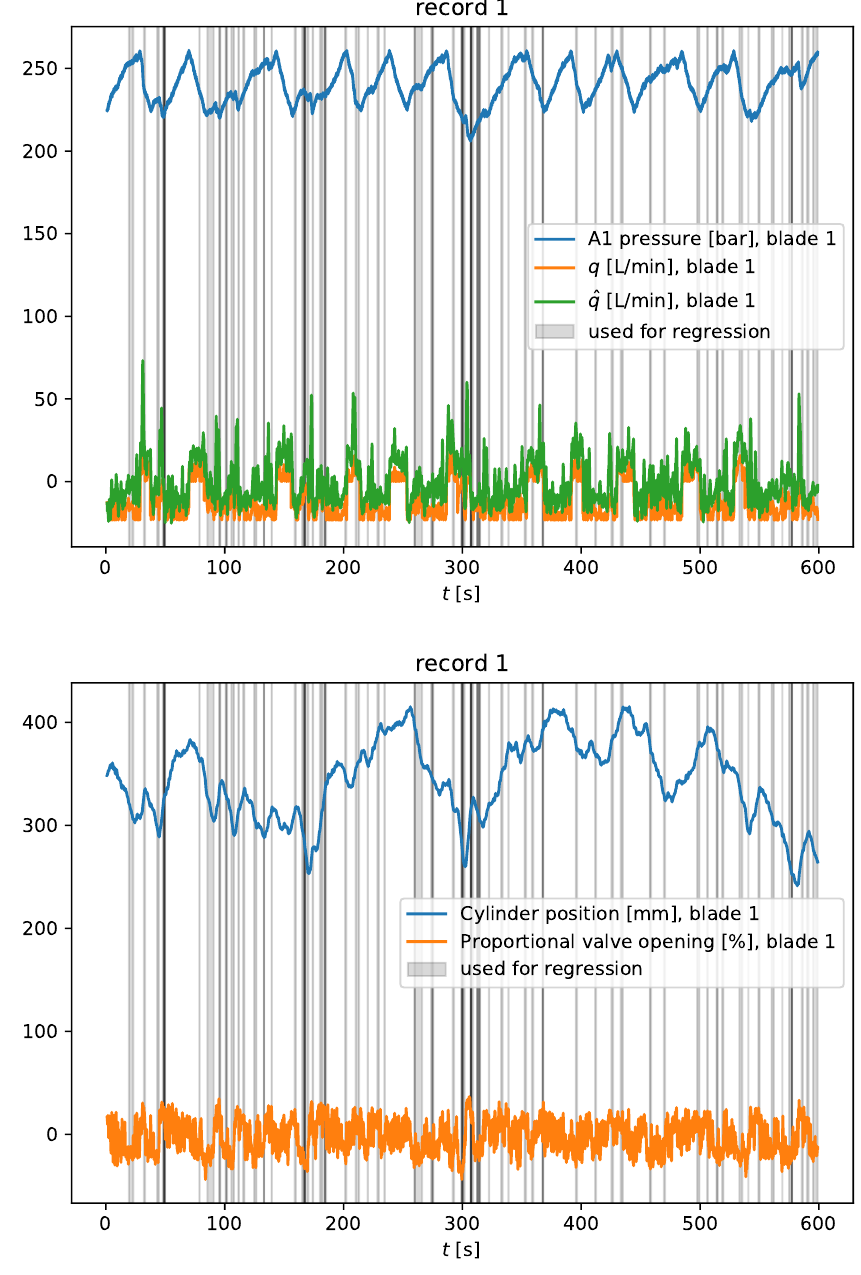
Figure 11. Data selection from a 10 min